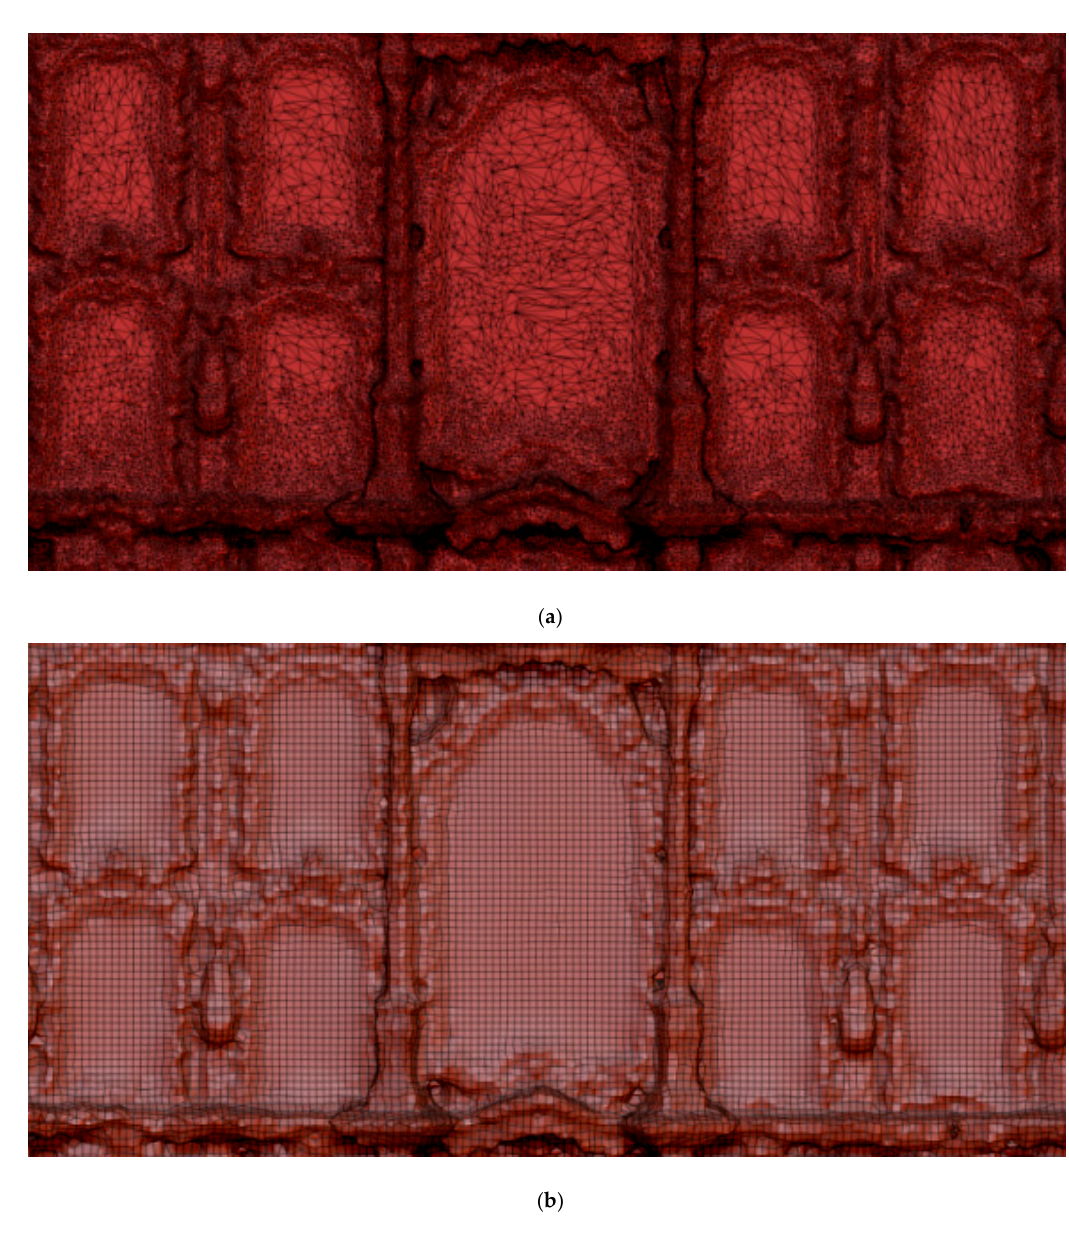
Figure 5. ( a ) Triangular polygon mesh; ( b ) the mesh converted to quadrilateral polygon system.